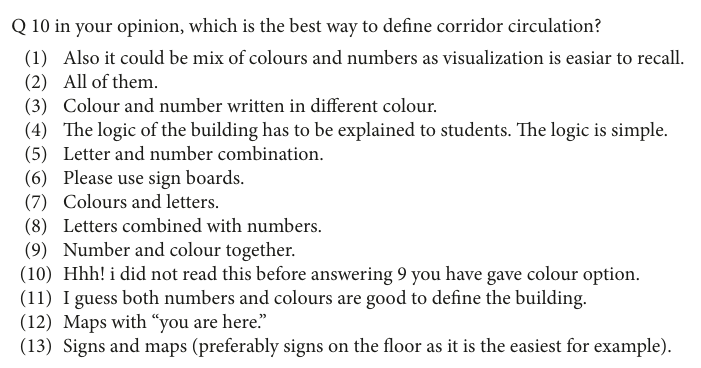
Figure 8 represents the plot of binary logistic model. By analysing Figure 8, it can be concluded that as time increases, the possibility of being dissatisfied decreases.